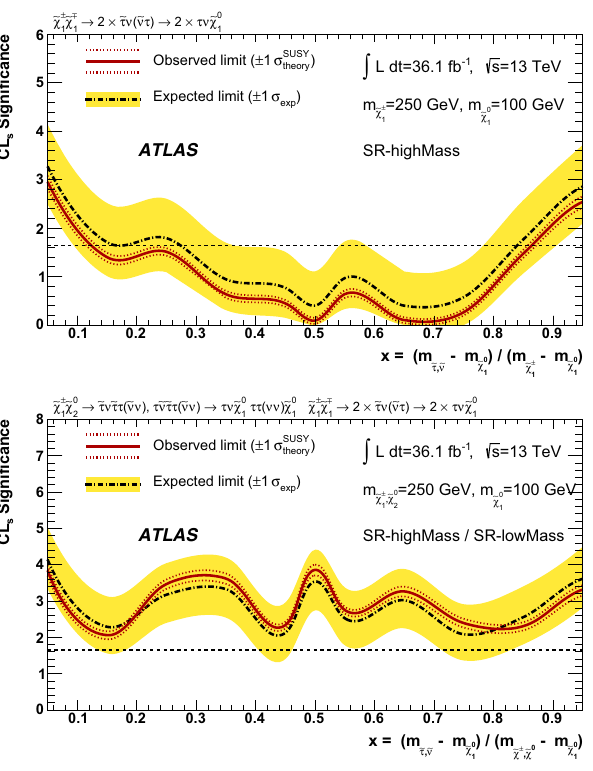
˜ χ − ˜ χ 0 ˜ χ + ˜ χ ± 1 1 and 1 2 production (bottom). + ˜ χ − 1 1 production, while the SR with the best